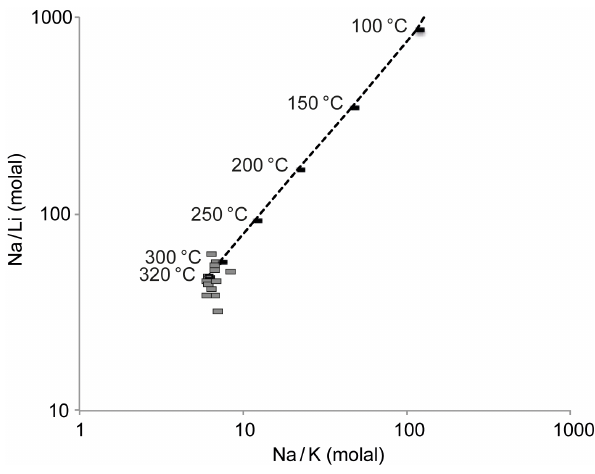
Figure 5. Na / K versus Na / Li ratio measured in quartz fluid inclu- sions (QzP2). The dashed line corresponds to geothermometry cal- ibrations from Verma and Santoyo (1997). The dataset indicates a temperature growth at 300–320 ◦